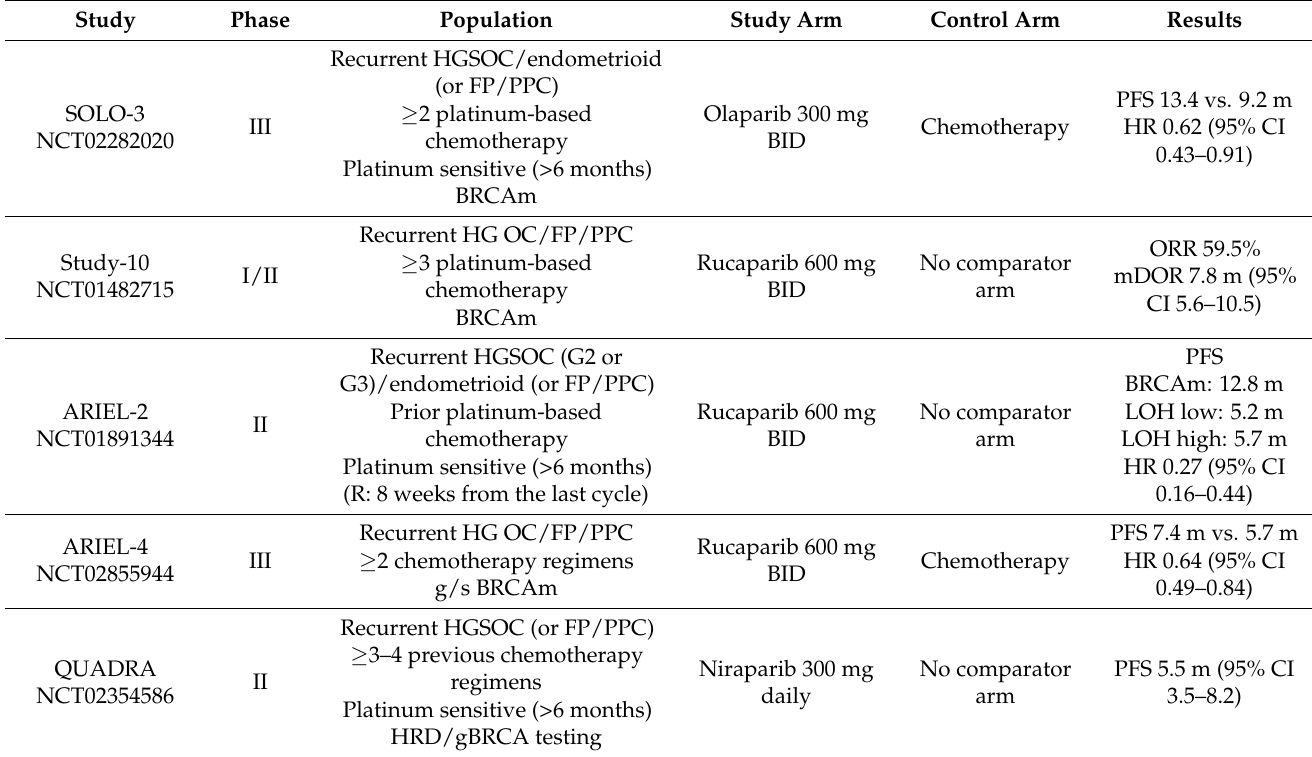
Table 4. Clinical trials of PARP inhibitors as single agent